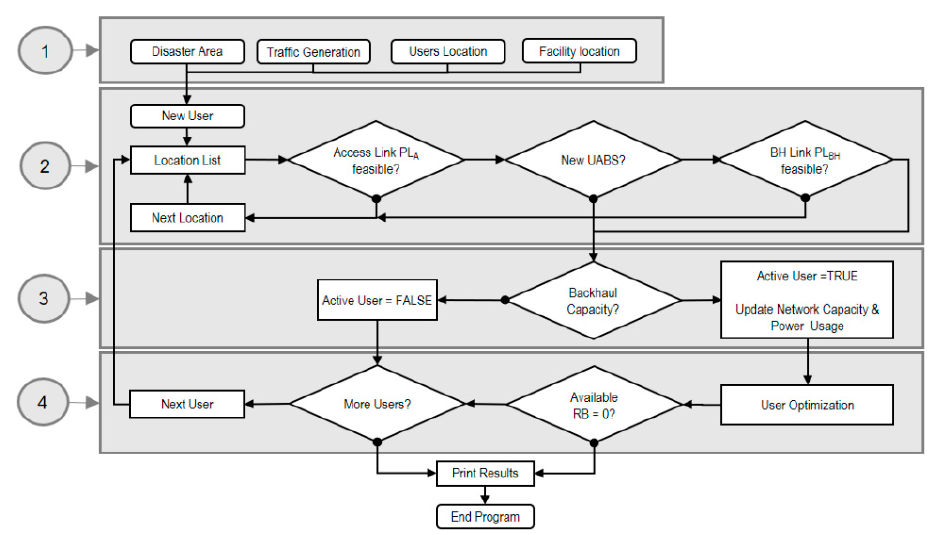
Figure 3. Flow diagram of the algorithm implemented for backhaul analysis.